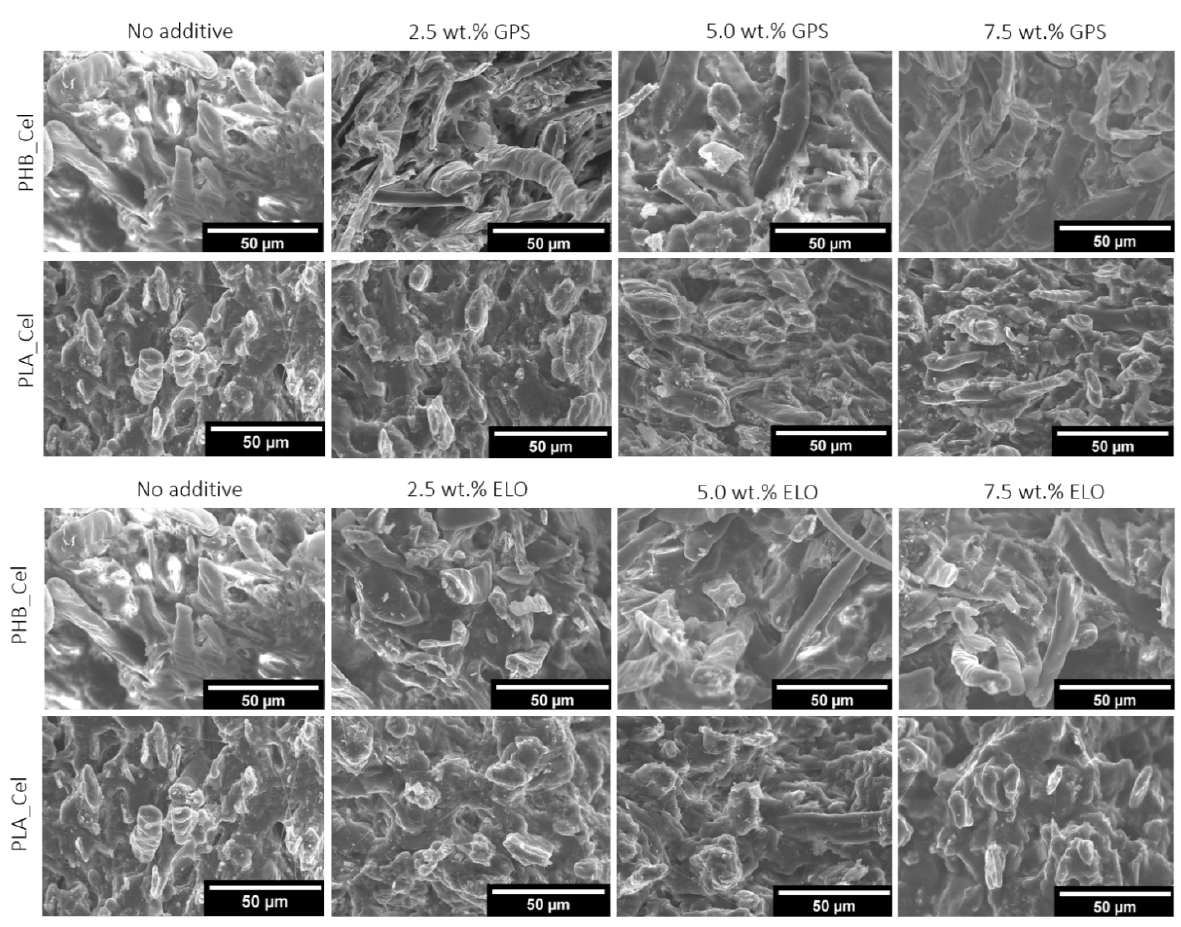
Figure 2. SEM micrographs of the fractured surfaces of PHB- and PLA-based composites without additives and with different contents of GPS and ELO additives.